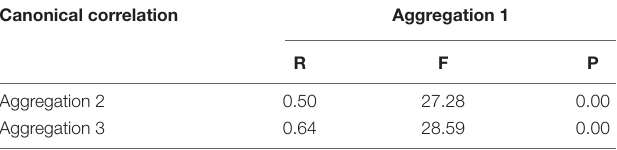
TABLE 5 | Correlation between LSIA, immunity and physical health ( n =